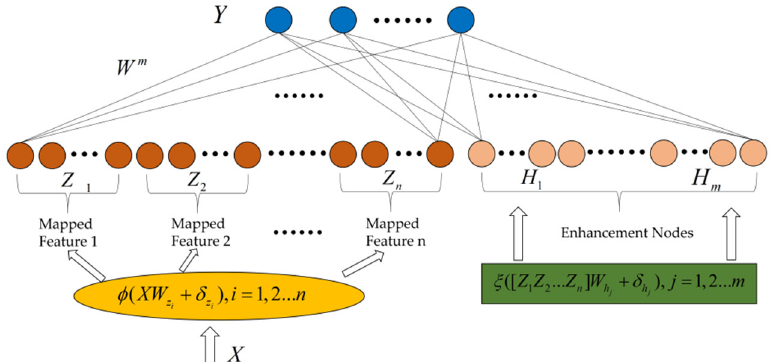
Figure 1. Structure of the BLS network. The Yellow ellipse on the left is the calculation formula for converting input data into feature nodes, the earthy yellow circle on the left is the generated feature nodes, the green rectangle on the right is the calculation formula for converting the left feature nodes into enhancement nodes, the light yellow circle on the right is the generated enhancement nodes, and the blue circle on the top is the output.